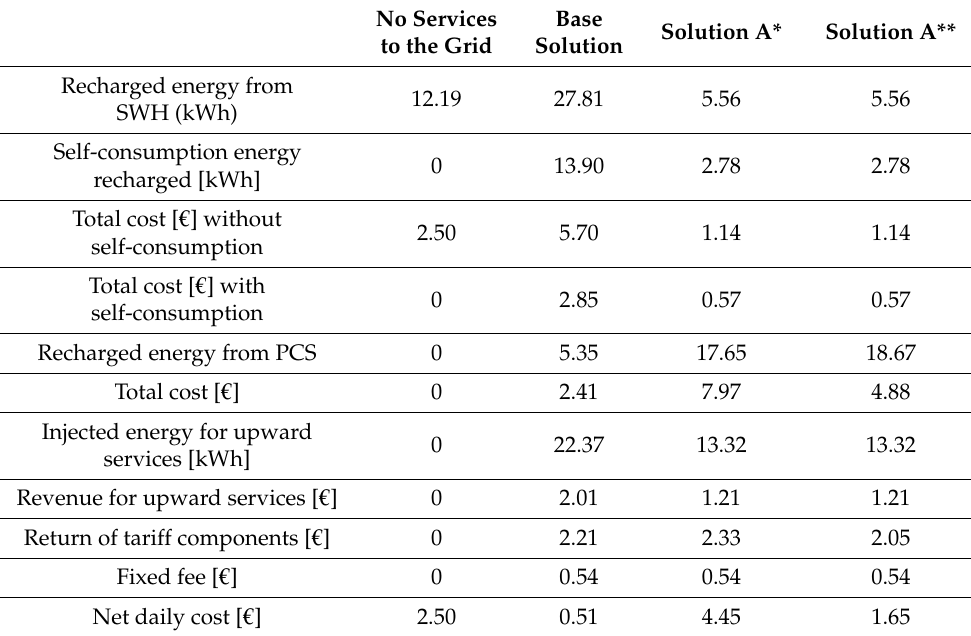
Table 27. Results for mobility pattern 1—UVAM (Scenario C).